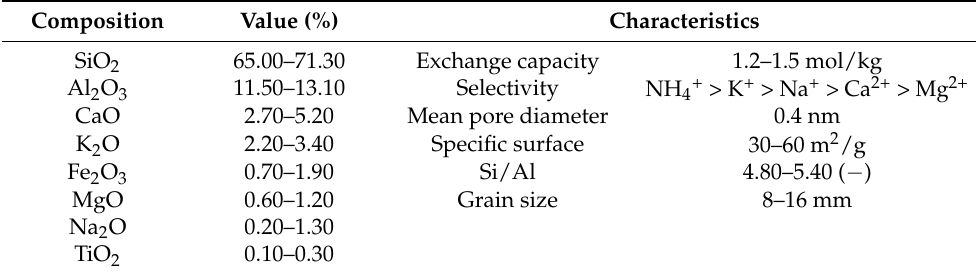
Table 1. Chemical composition and zeolite characteristics, data provided by supplier.